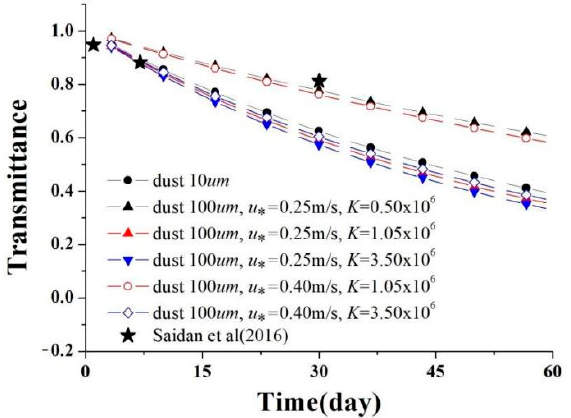
Figure 14. Comparison of the settlement amount and deposition rate of fine sand particles with different cohesion parameters and wind speeds. ( left ) Settlement amount. ( right ) Dust deposition rate.